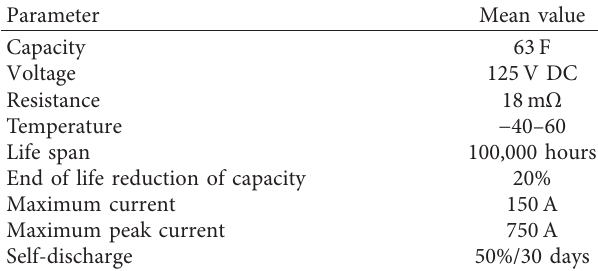
Table 4: Parameters of the